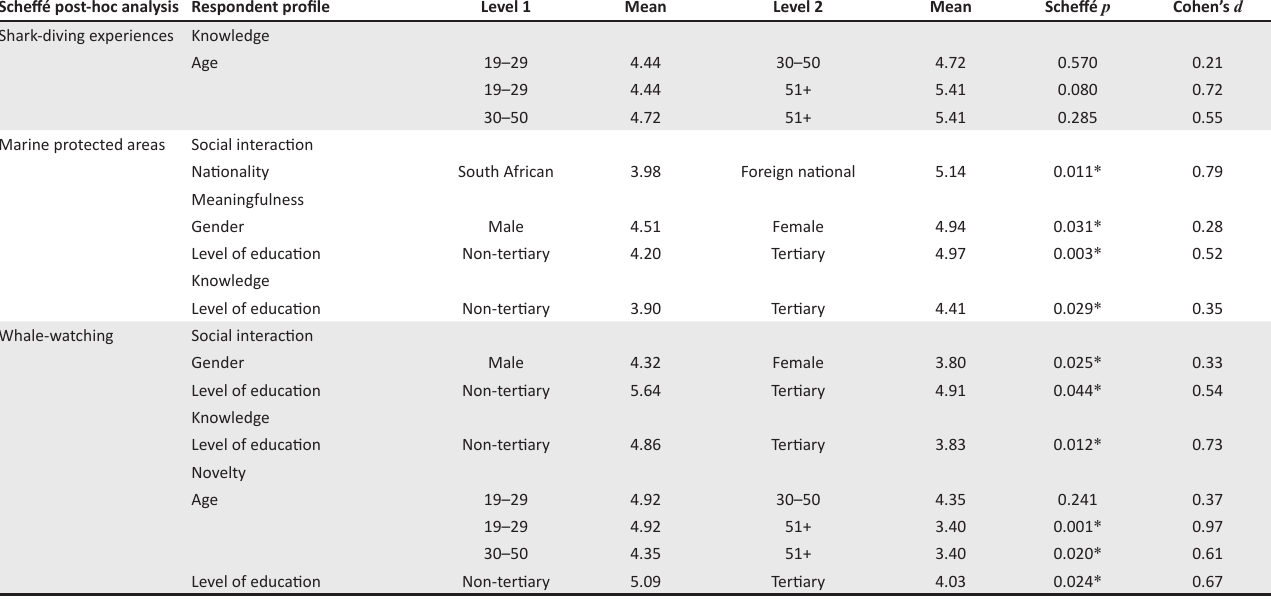
TABLE 9: Scheffé post-hoc analysis: Individual activities. Scheffé post-hoc analysis Respondent